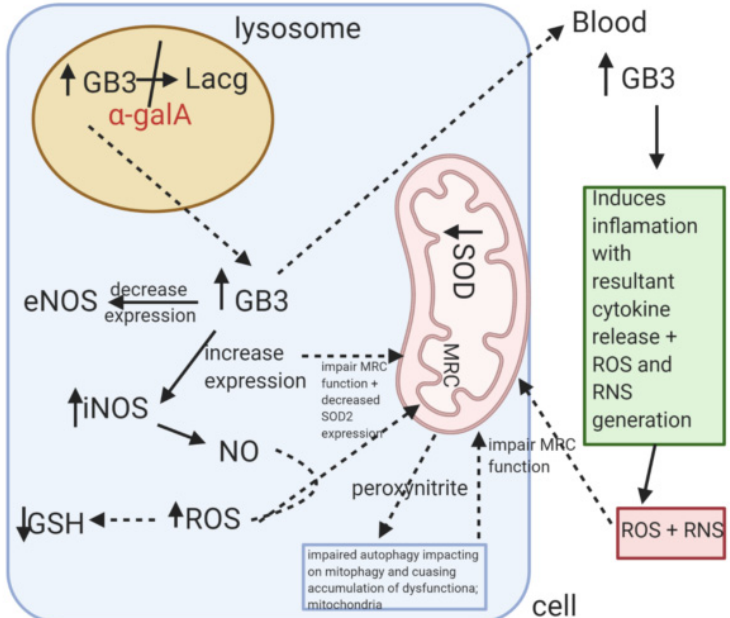
Figure 6. Putative causes of mitochondrial dysfunction in Fabry disease. GB3: globotriaosylceramide. Lacg: Lacoglyceramide. α -galA: alpha-galactosidase A. SOD-2: Superoxide dismutase-2. eNOS:endothelial nitric oxide synthase. iNOS: inducible nitric oxide synthase. MRC: Mitochondrial respiratory chain. GSH: Reduced glutathione. ROS: Reactive oxygen species. RNS: Reactive oxygen species. NO: Nitric oxide.